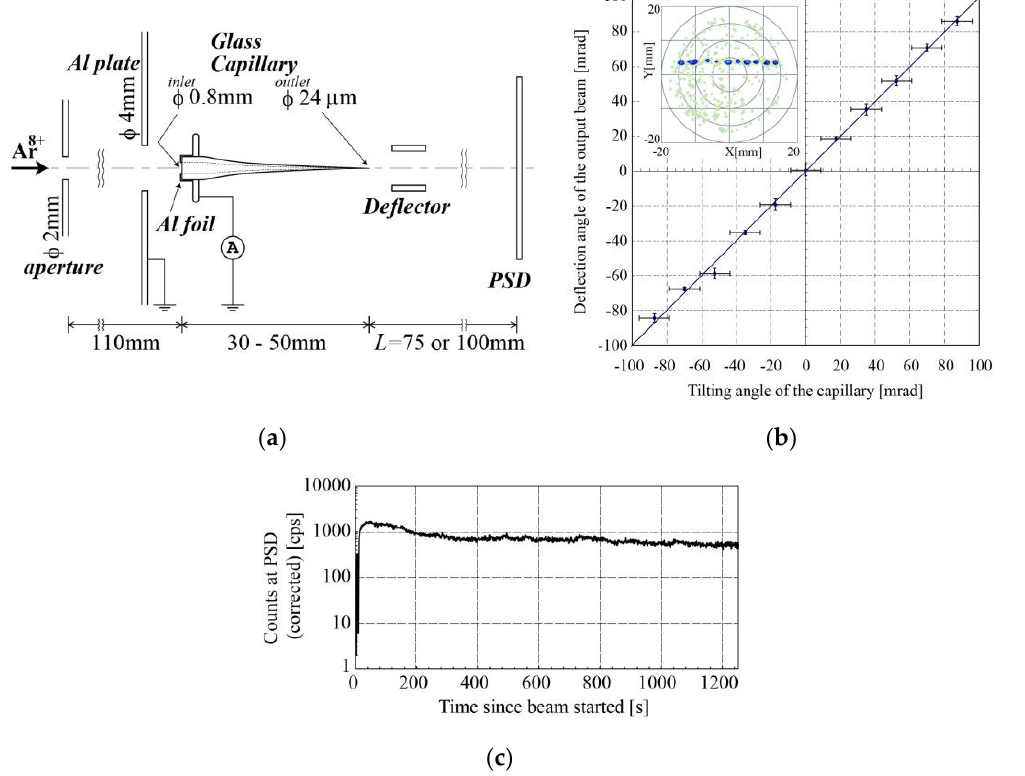
Figure 6. ( a ) Experimental setup (reprinted from [1], with the permission of the American Institute of Physics (AIP) Publishing); ( b ) guiding effect (reprinted from [1], with the permission of AIP Publishing); and ( c ) time evolution of the number of the transmitted ions (reprinted from [1], with the permission of AIP Publishing).